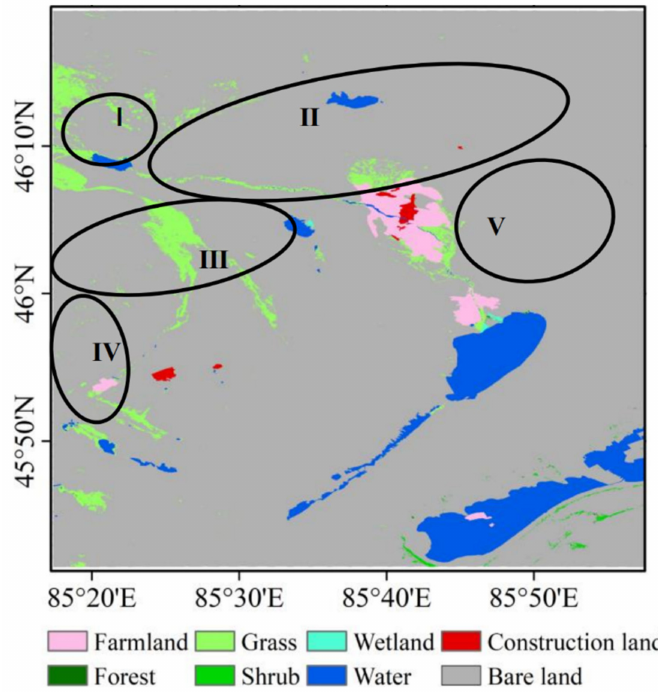
Figure 4. Land-use map of the study area overlain with the high-temperature anomaly